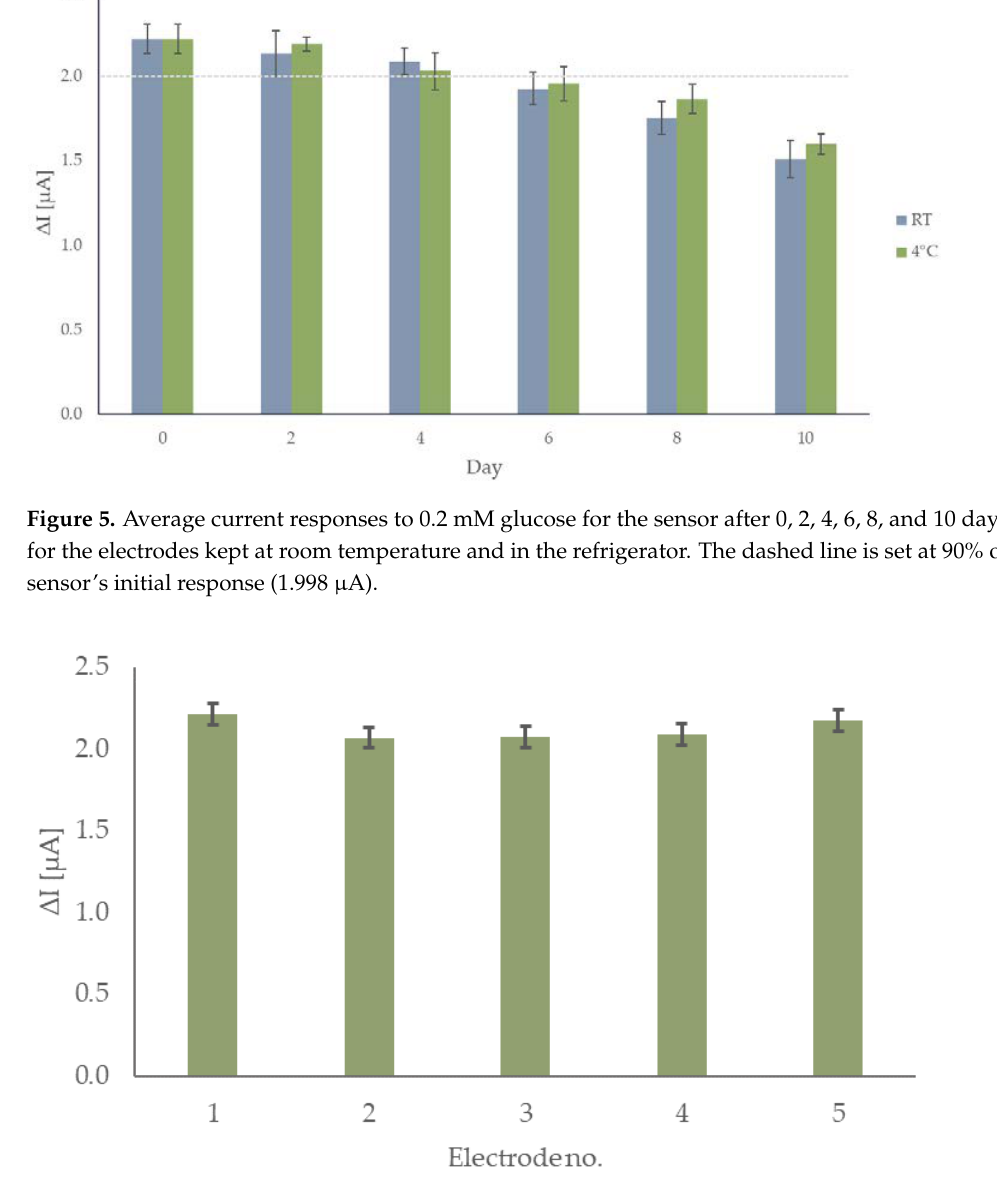
Figure 5. Average current responses to 0.2 mM glucose for the sensor after 0, 2, 4, 6, 8, and 10 days for the electrodes kept at room temperature and in the refrigerator. The dashed line is set at 90% of sensor’s initial response (1.998 µA).